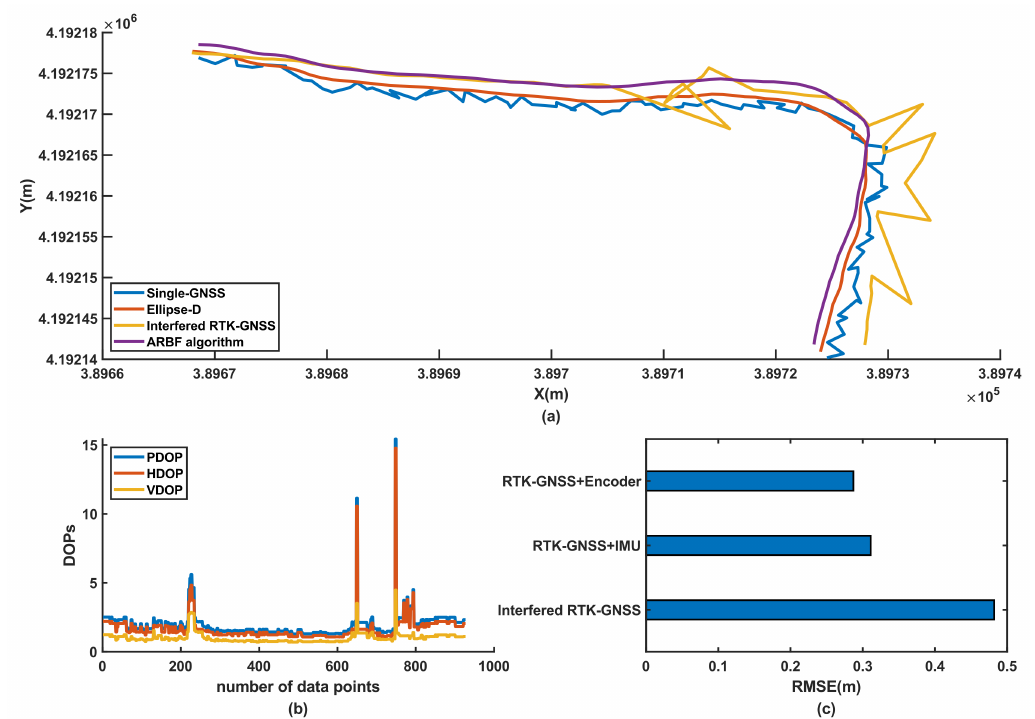
Figure 12. Experimental results of RTK-GNSS signal with interference: ( a ) position prediction results of the RTK-GNSS signal with interference; ( b ) DOP data of the RTK-GNSS in the experiment; ( c ) RMSE results of the